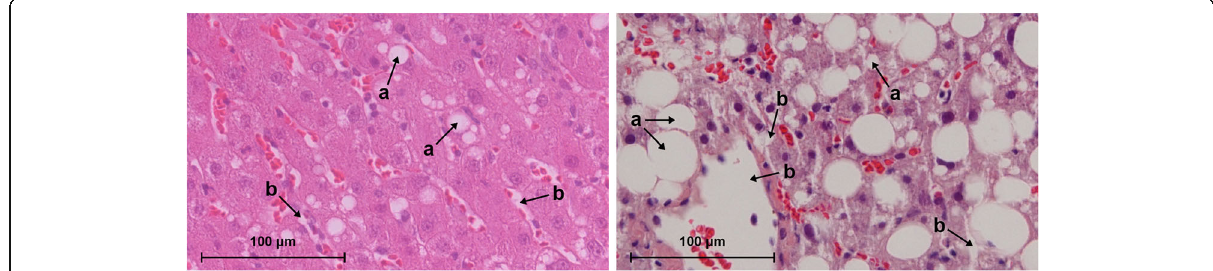
Fig. 1 Histological appearance of steatosis. Low-grade and high-grade steatosis are shown left and right, respectively. Fat droplets (a) and other empty spaces (b) are marked by arrows